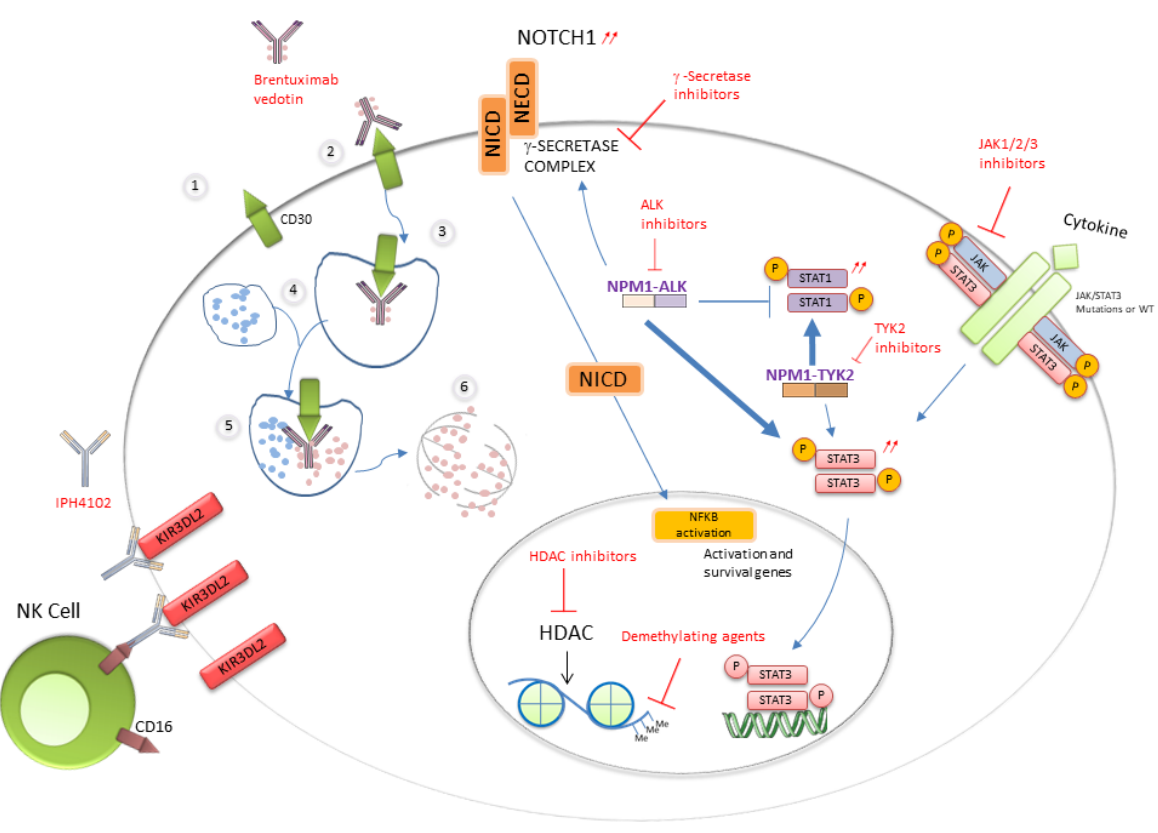
Figure 2. Activated pathways and therapeutic targets in ALCLs.